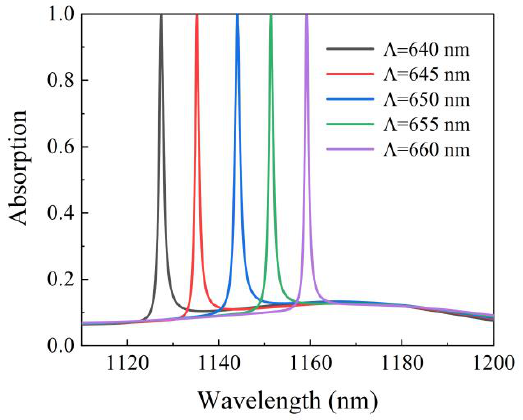
Figure 8. Changes in absorption while varying the period of the absorber structure.